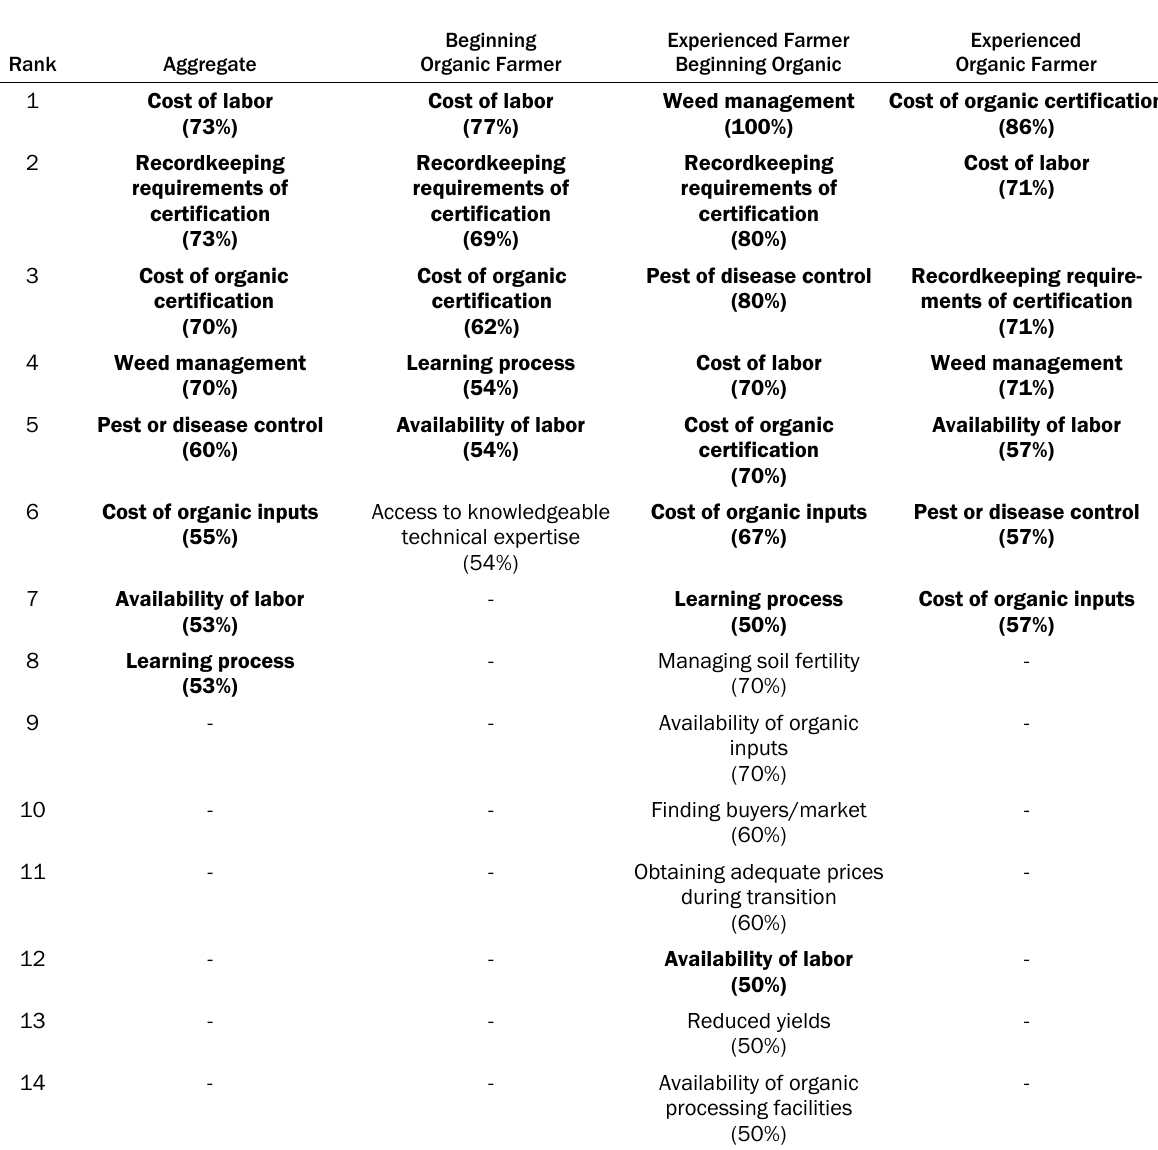
Table 8. Obstacles of Concern for Majority of Each Farmer